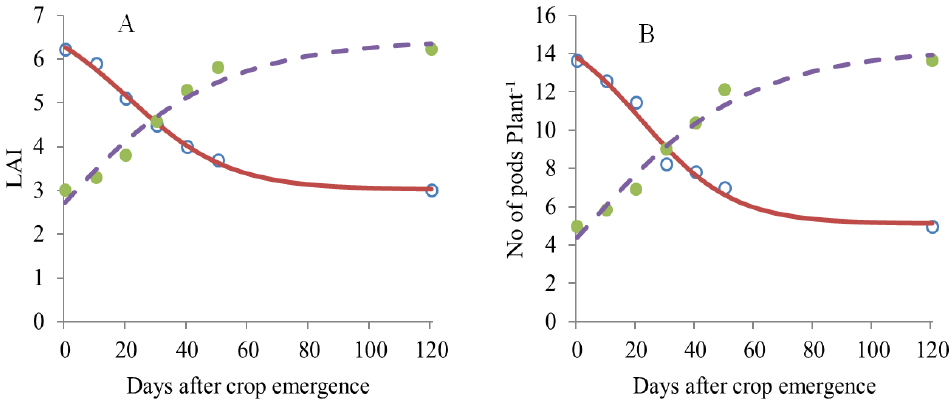
Fig. 3. Effect of increase in duration of weed interference (empty circles) and weed free periods (dots) on dry bean LAI (A) and pods number (B) using logistic and Gompertz equations. Parameter values for fitted curves are given in Tab. 3 Tab. 3. Parameters estimates of the logistic model used to Tab. 4. Parameters estimates of the Gompertz model used to calculate the effect of weed-infested treatments on crop traits calculate the effect of weed-free treatments on crop traits Crop traits